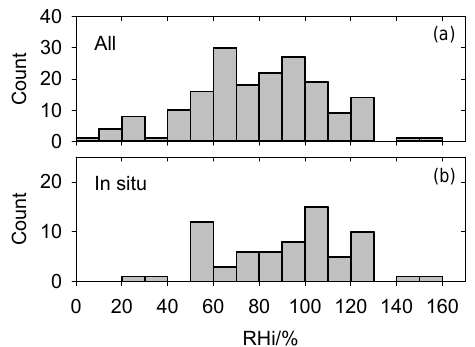
Figure 7. Histogram of relative humidity over ice (RH i ) for all cases (top) and for in situ cases (bottom).